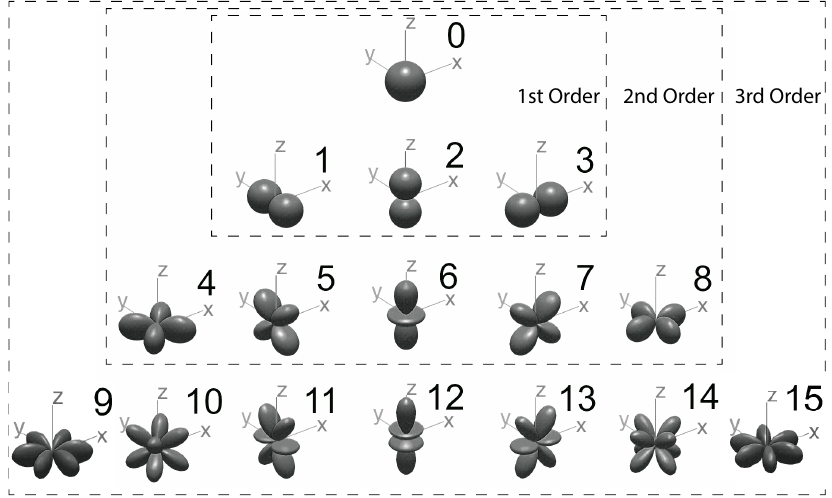
Figure 1. Ambisonics spherical harmonics for orders up to three. FOA includes the top two lines of basis functions (4 channels) and 3OA includes all four lines (16 channels). The ACN channels 2, 6 and 12 contain only vertical